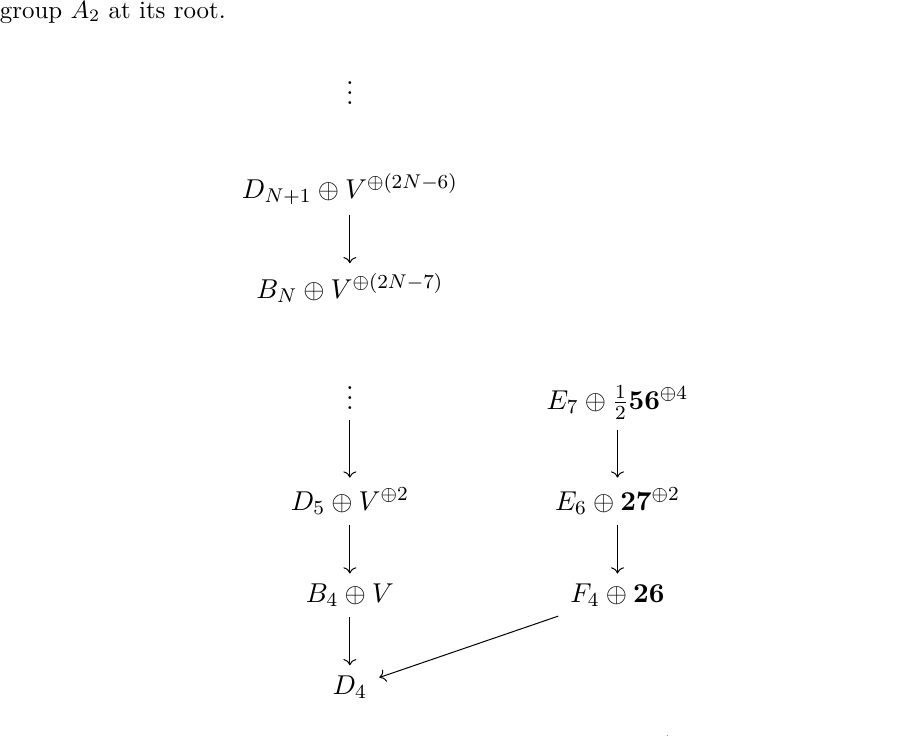
Figure 7 . Finite length Higgsing tree over the base O ( − 3) → P 1 , with the maximally Higgsed gauge group A at its root. 2